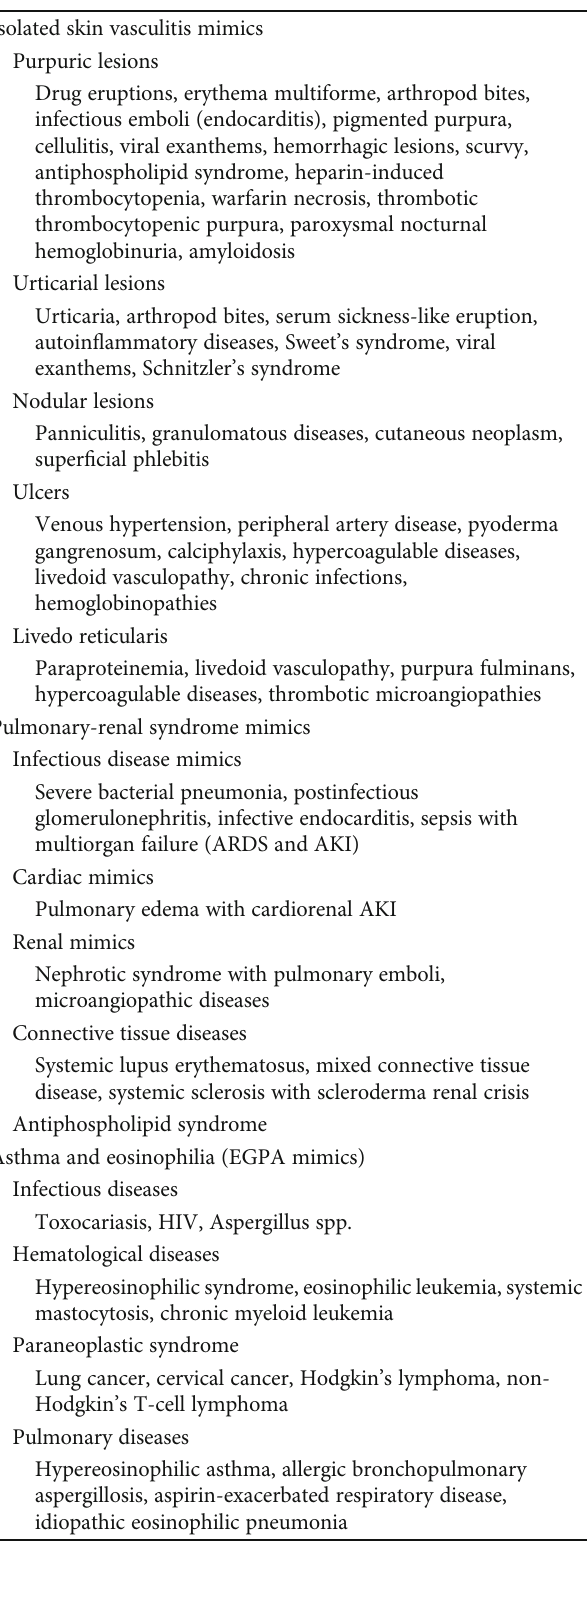
Table 4: Conditions that mimic SVV. Table 4: